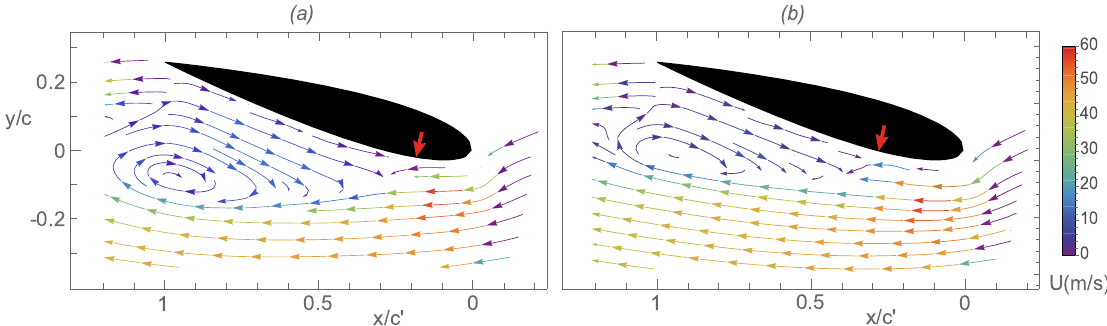
Figure 15. ( a ) Plasma-off and ( b ) plasma-on flow field at T A for α = 14.5 ◦ and U ∞ = 30 m/s. Moving along the span, the next examined tip is T B . The plasma-off condition is reported in